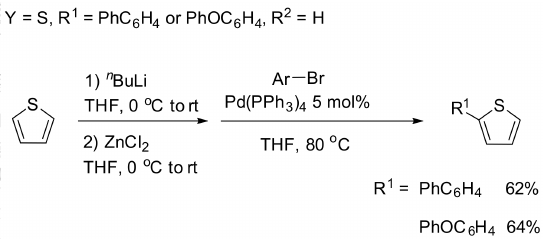
Scheme 2. Preparation of